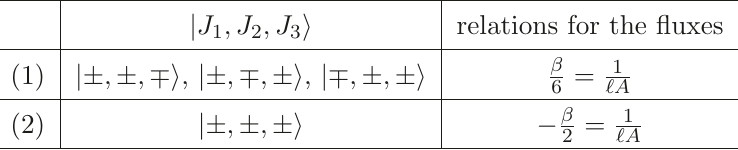
Table 6 . Decomposition of (3.71) KSE into